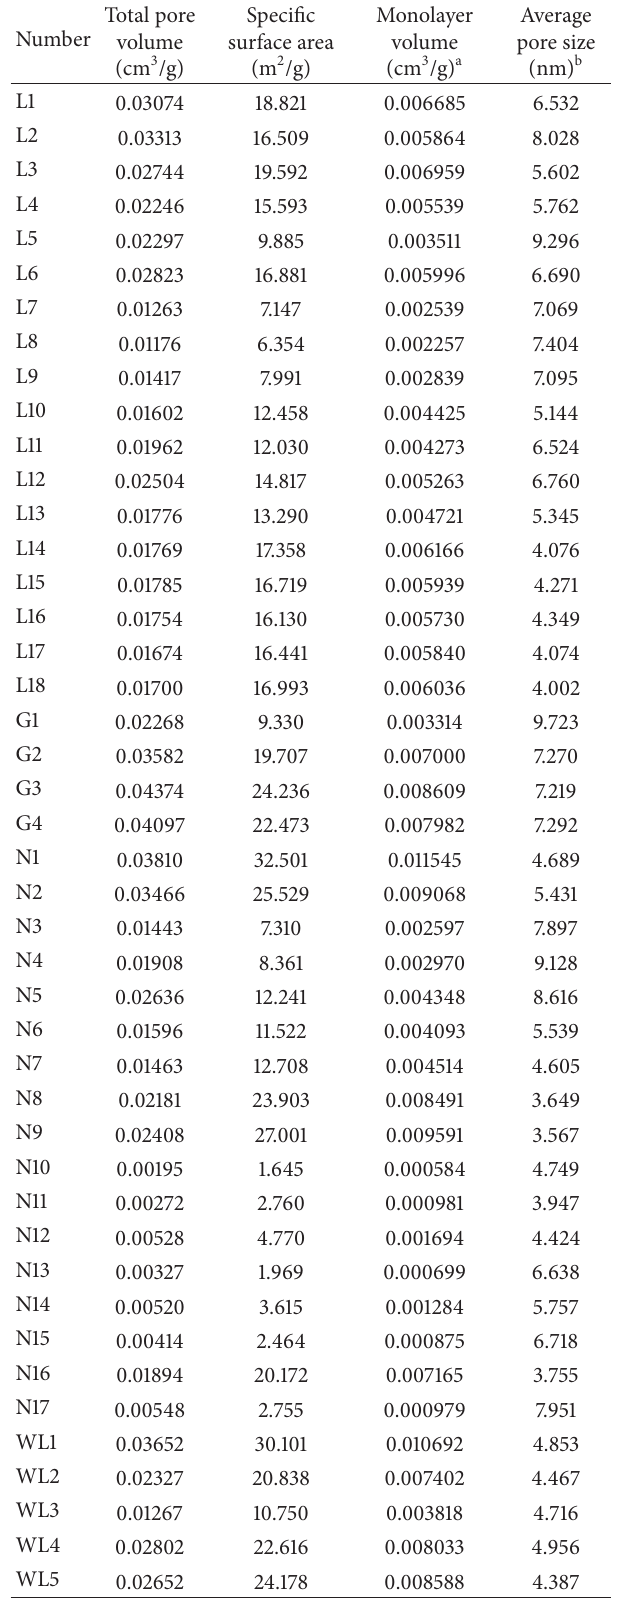
Table 2: Pore structure parameters of shale samples from N adsorption